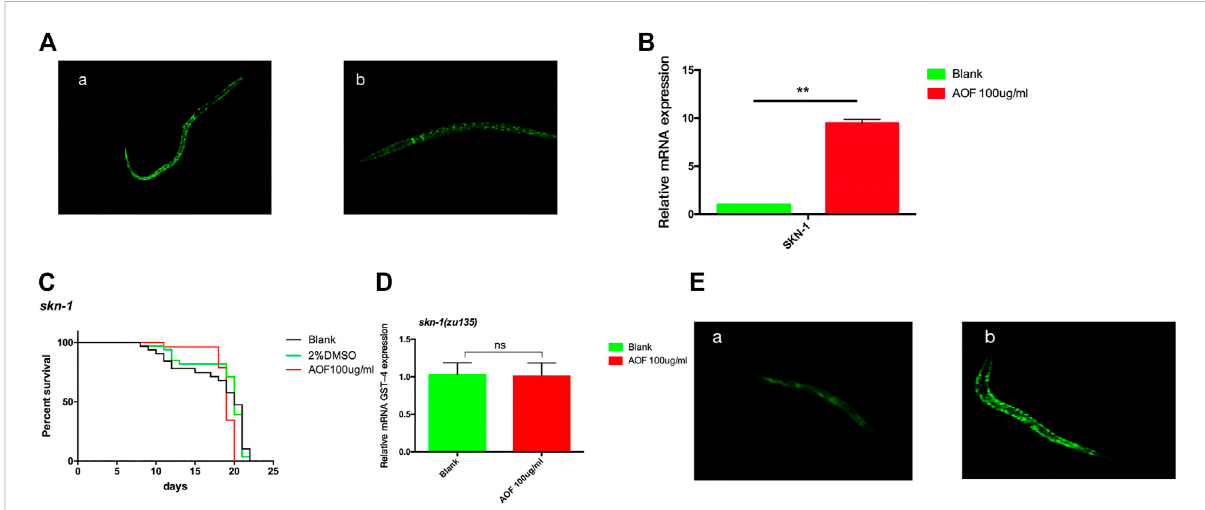
FIGURE 10 The role of SKN-1 inthe anti-aging effects of AOF. (A) A representative imageof SKN-1:GFP in strain skn-1(zu135) for (A) , control group and (B) , 100 μ g/mlAOF group. (B) The expression ofskn-1 intheAOFtreatmentgroup vscontrol group. (C) Effect ofAOF onthelifespan ofthe skn-1(zu135) mutant. (D) The relative GST-4 mRNA expression in skn-1(zu135) mutants. (E) Fluorescence intensity of GST-4:GFP after AOF in (A) , control group and (B) , 100 μ g/ml AOF group.Data are the mean ± SD ( n = 3). **p < 0.01